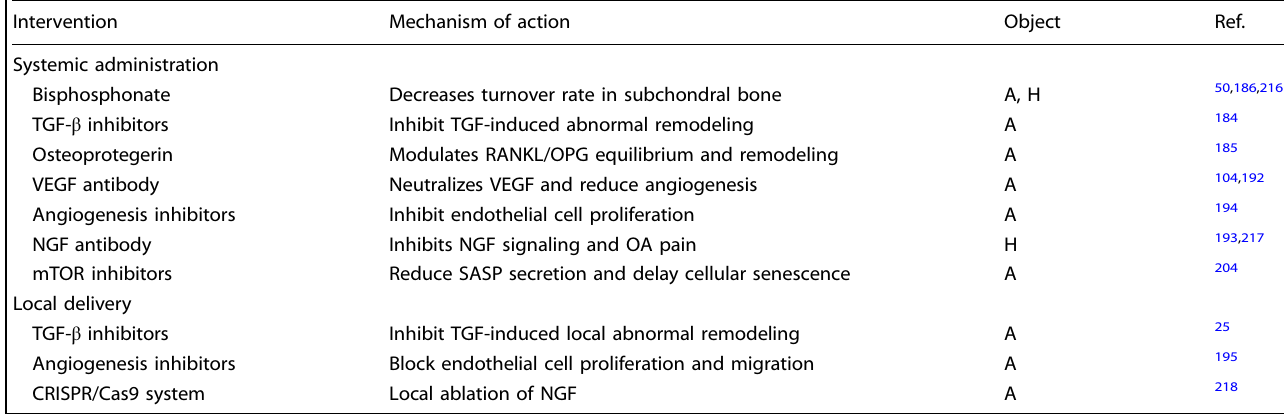
Table 1. Promising pharmacological interventions targeting subchondral bone in OA Intervention Mechanism of action Ref.